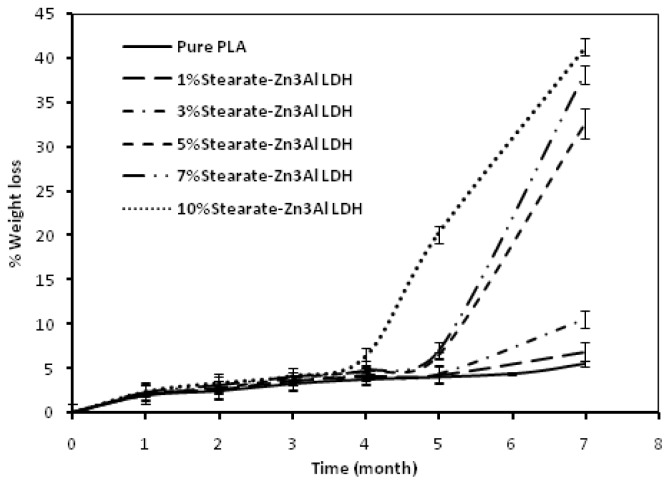
Weight losses of pure PLA and its stearate-Zn3Al LDH nanocomposites in soil for up to seven months.